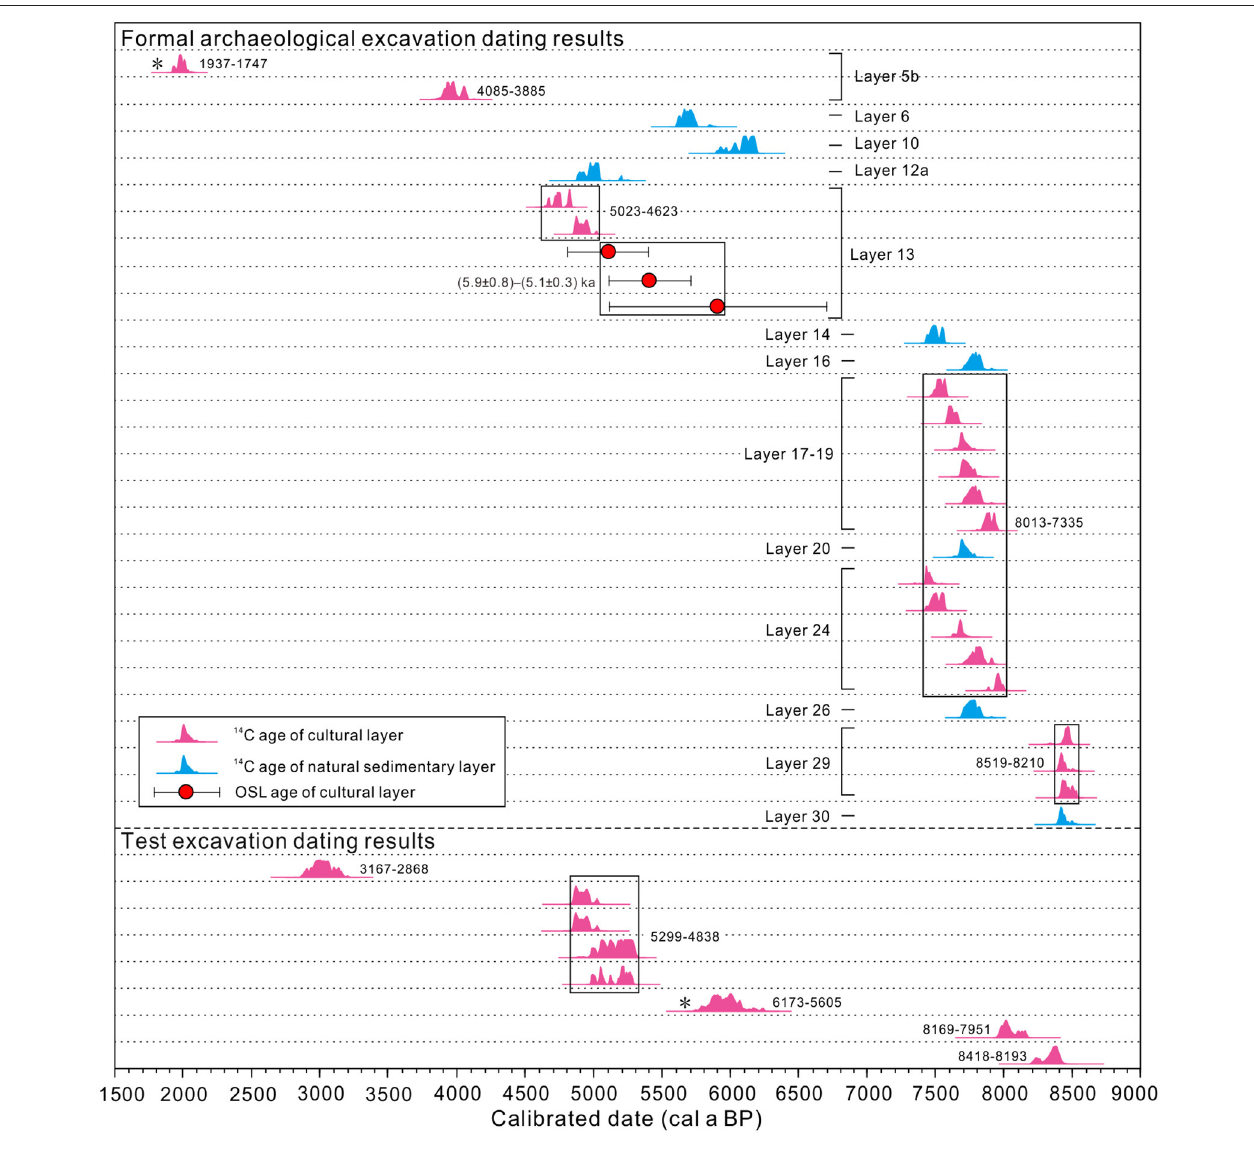
FIGURE 3 | Calibrated radiocarbon and OSL age distributions from Shalongka site (Details of the age are given in Table 1 and Supplementary Table S2 ). *Indicates that the dating results are inconsistent with the archaeological cultural record.